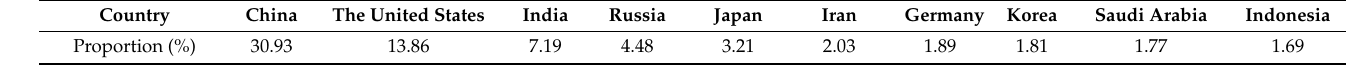
Table 2. Proportion of carbon emissions in major countries in 2020.